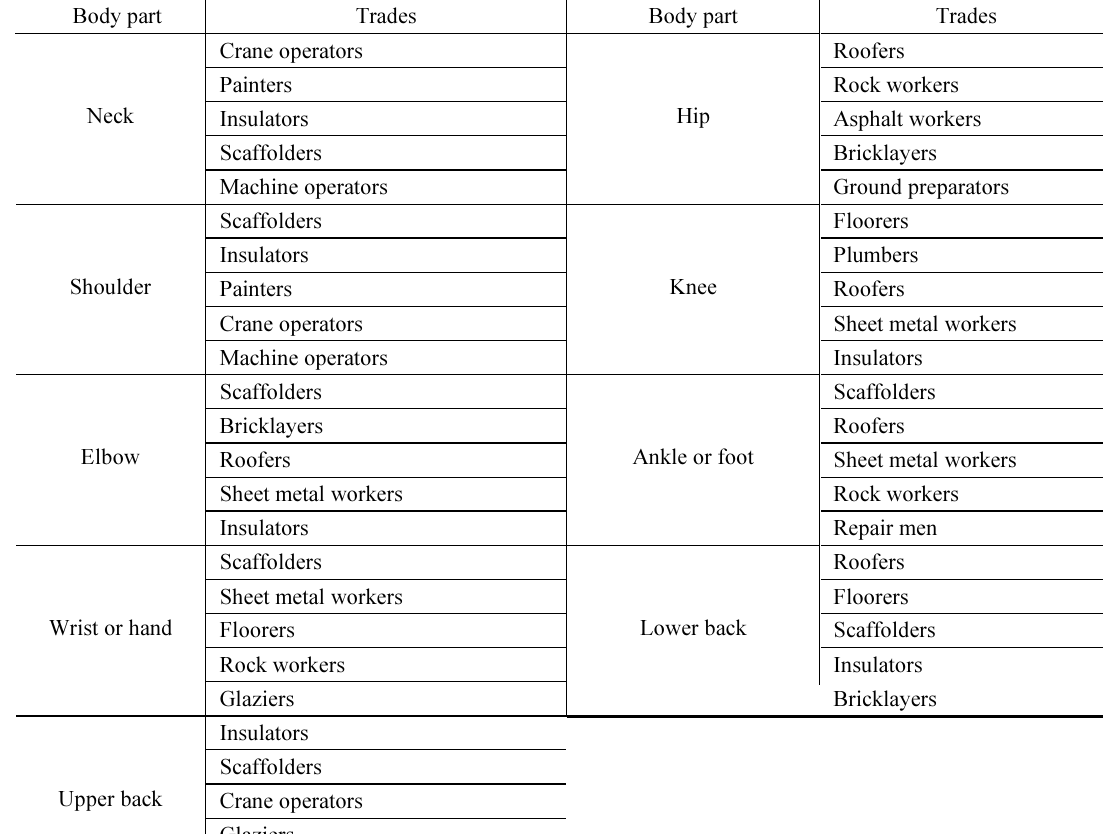
Hip Ground preparators Knee Insulators Ankle or foot Repair men Lower back Bricklayers